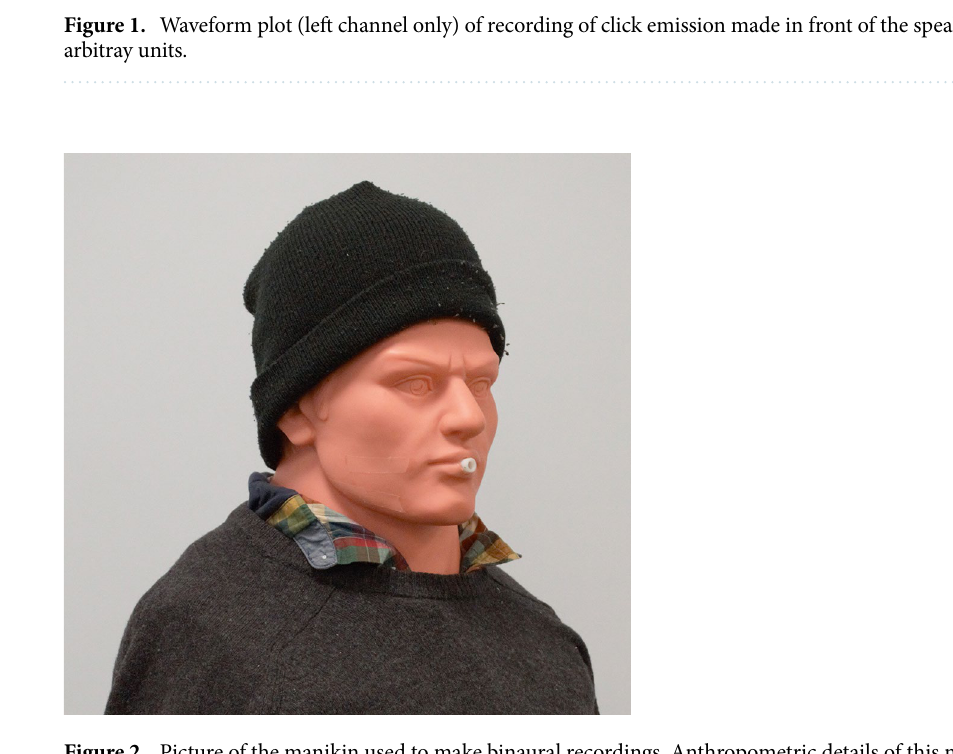
Figure 2. Picture of the manikin used to make binaural recordings. Anthropometric details of this manikin have been published elsewhere 12 . The center of the speaker used to generate emissions was placed at the mouth of the manikin (marked by a small